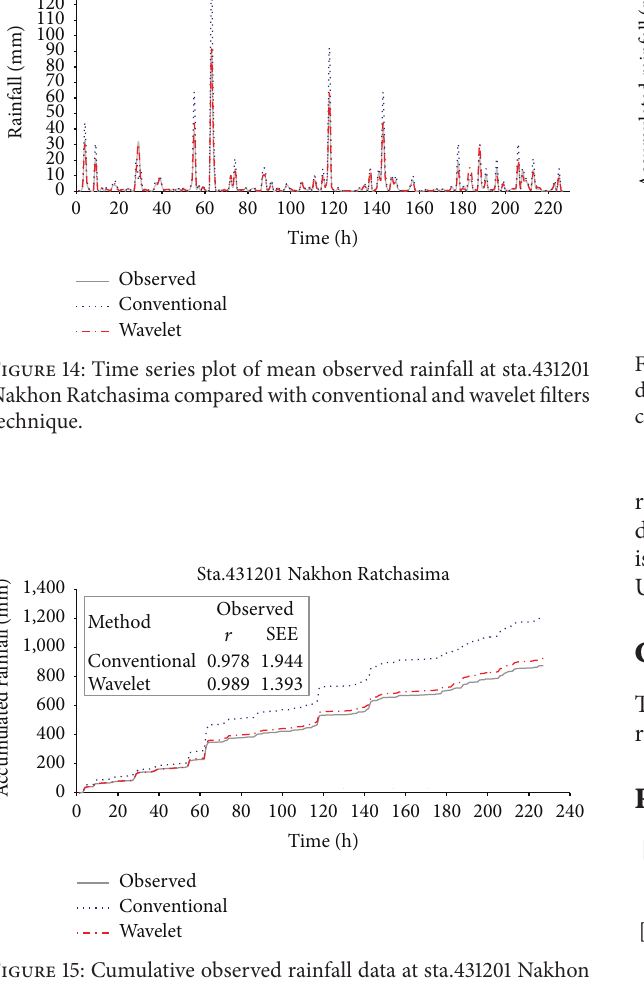
Figure 15: Cumulative observed rainfall data at sta.431201 Nakhon Ratchasima during 1 June–31 October 2011 for verification compared with conventional and wavelet filters technique.